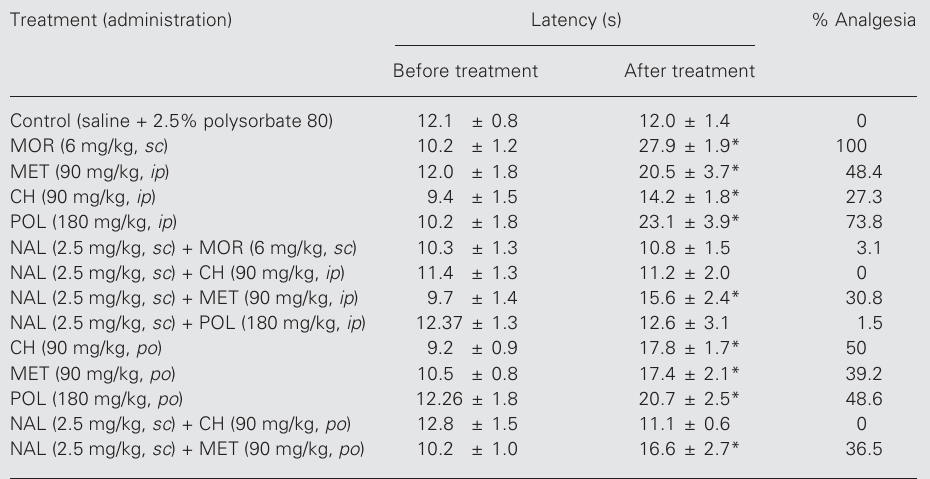
Table 1. Antincociceptive effect of cyclohexane (CH) and methanol (MET) extracts of the aerial parts of Hypericum caprifoliatum and of the cyclohexane extract of aerial parts of H. polyanthemum (POL) in mice submitted to the hot-plate